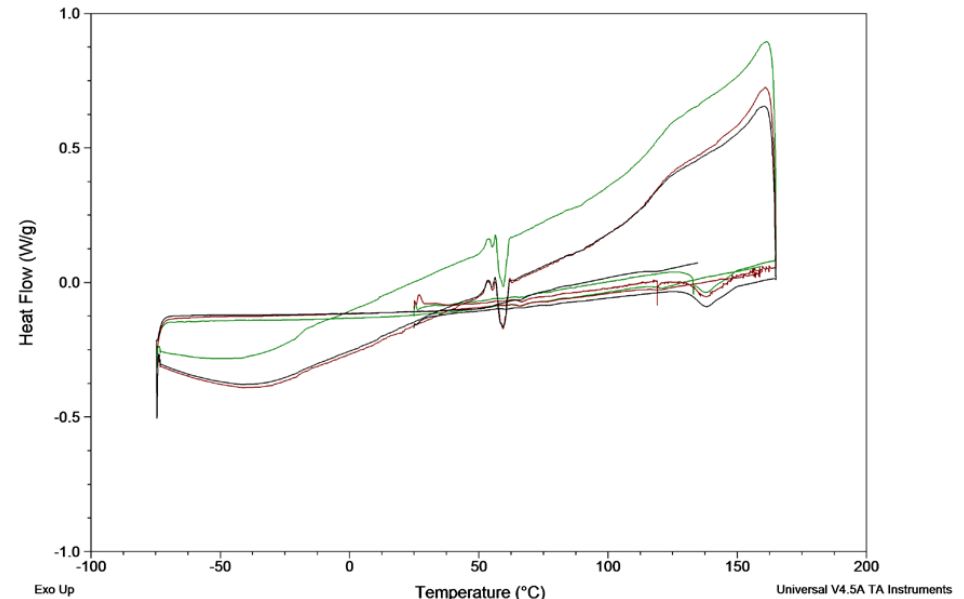
Figure 2. DSC of venetoclax batch 1 (1705150). A heat–cool–heat protocol was used to determine the glass-forming ability (n = 3).